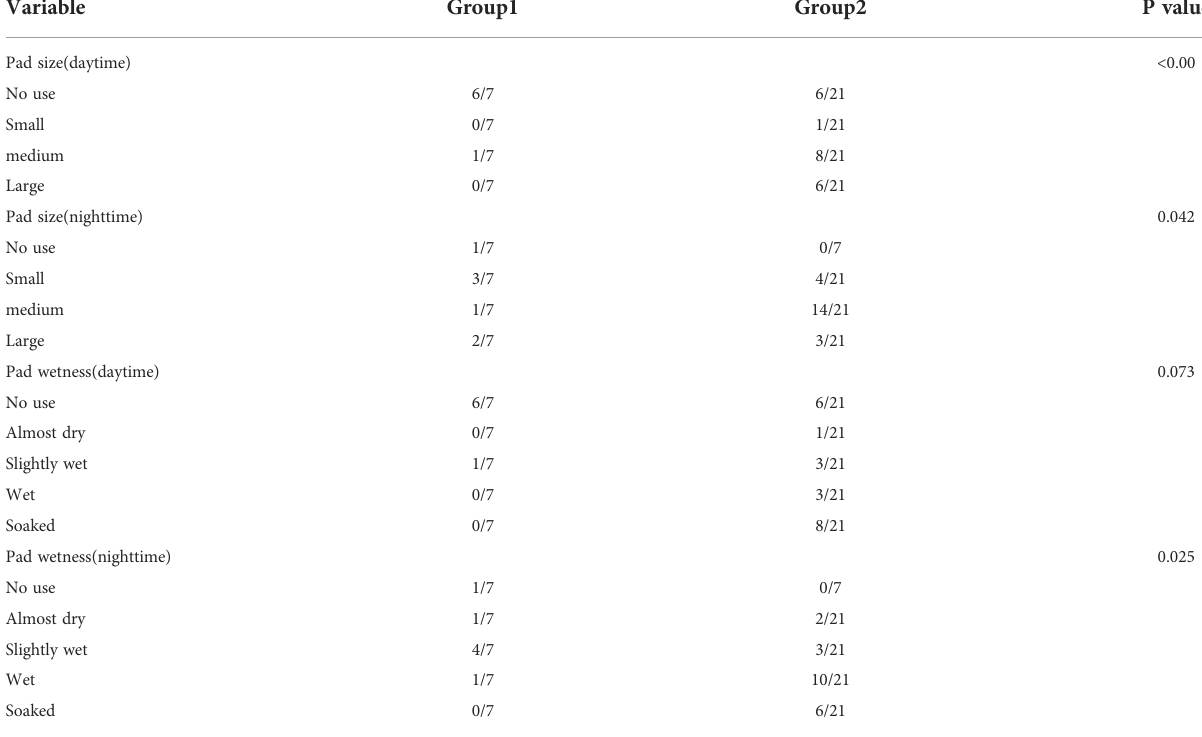
TABLE 4 Patterns of mucus leakage for two groups.